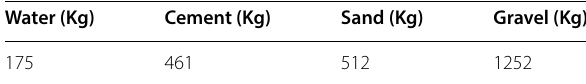
Table 1 Mix proportion of